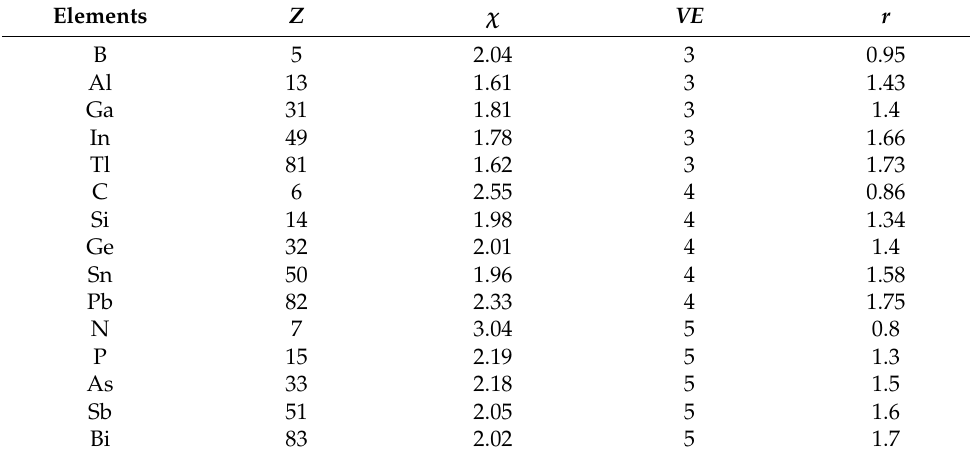
Table 1. The input features used for SISSO training, which includes the atomic number ( Z ), the Pauling electronegativity ( χ , in units of eV), the number of valence electrons ( VE ), and the atomic radius ( r , in units of Å) for group III (B, Al, Ga, In, and Ta), group IV (C, Si, Ge, Sn, and Pb), and group V elements (N, P, As, Sb, and Bi). Z χ Z χ VE